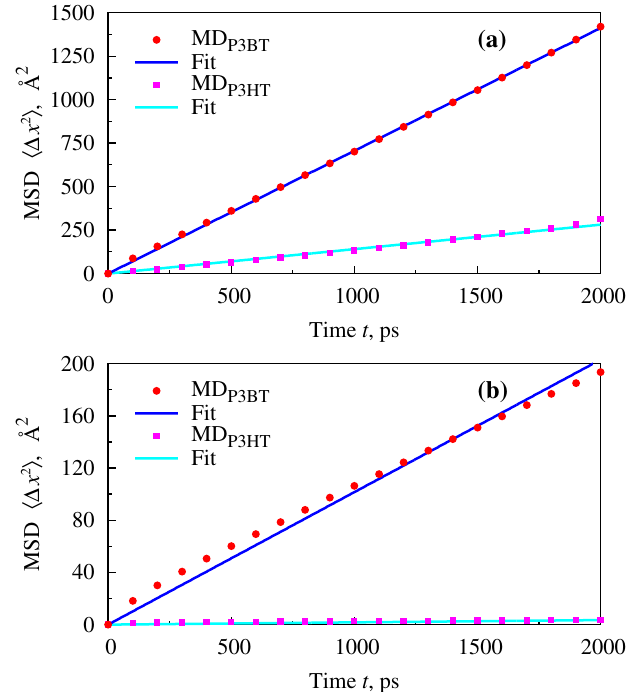
Figure 6. MD results for mean square displacement of PCBM in its blend with P3BT or P3HT monomers at infinite dilution and T = 400 K. ( a ) ρ blend = 0.933 g/cm 3 ; ( b ) ρ blend = 1.15 g/cm 3 . Symbols denote the Mean Square Displacement (MSD) values sampled from data every 200 time steps, and lines are least-squares Marquardt–Levenberg algorithm [71] linear fits to